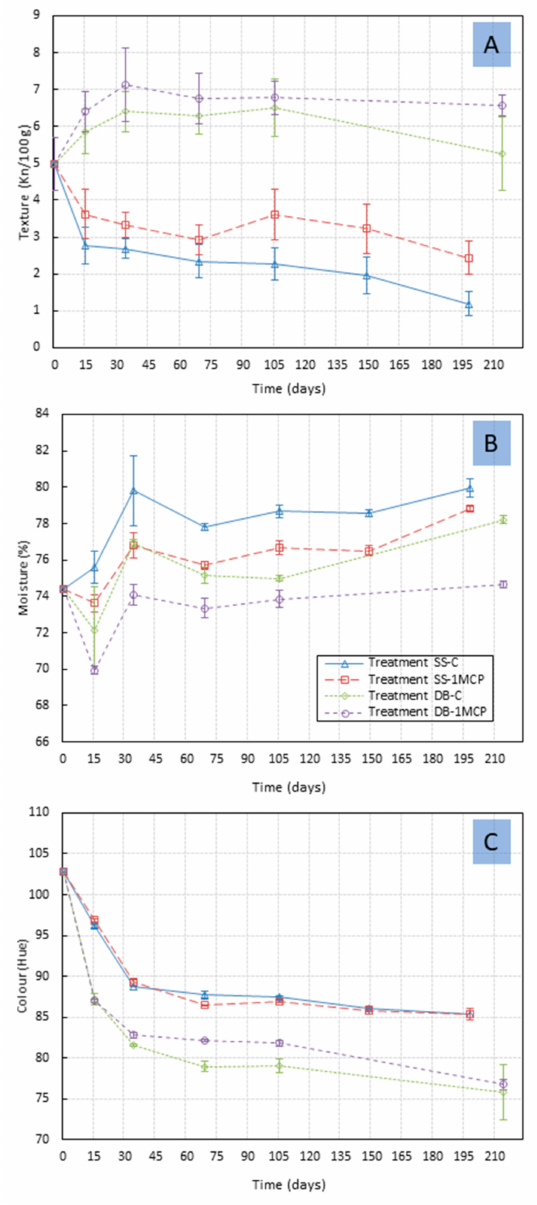
Figure 3. Evolution in fruits of instrumental texture ( A ), humidity ( B ), and instrumental colour measured as hue angle ( C ) during fermentation in the different treatments assayed in this work. DB-C: control directly brined olives, DB-1MCP: directly brined olives treated with 1-MCP,